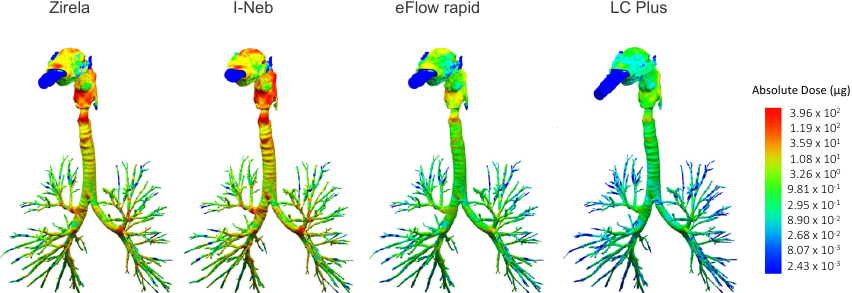
Figure 3. Differential levofloxacin deposition pattern across nebulisers in the three-dimensional reconstruction of the airway tree of a representative patient. The colour scale defines the absolute deposited levofloxacin in μ g. The dashed line delineates the limit between extrathoracic and intrathoracic deposition.